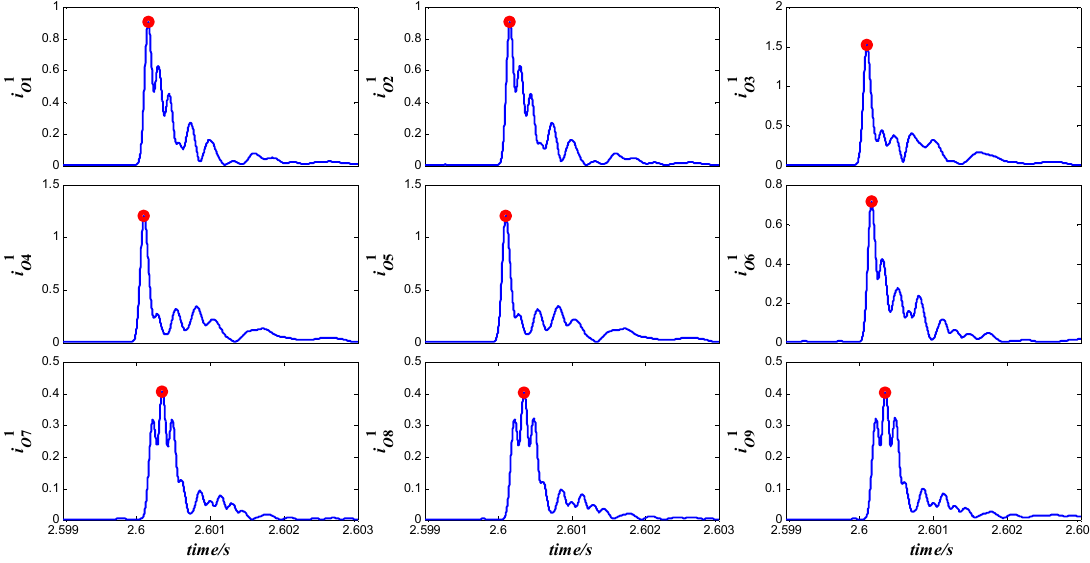
Figure 10. Modulus of wavelet coefficients of 1-mode currents that are measured by the nine observers.